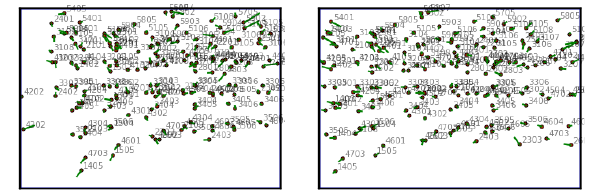
Figure 4. Point distribution of left and right stereo calibration imagery for the campaign in August 2015